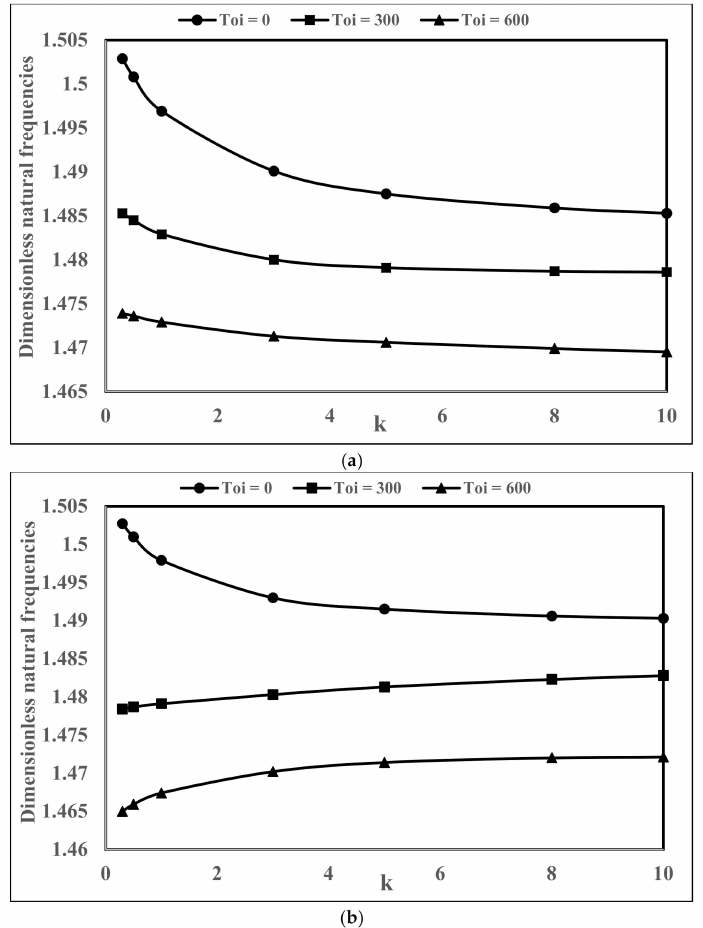
Figure 9. ( a ) Variation in DNF of an FG rotor system at di ff erent thermal gradients without porosity. ( b ) Variation in DNFs of a porous FG rotor system for α = 0.2 at di ff erent thermal